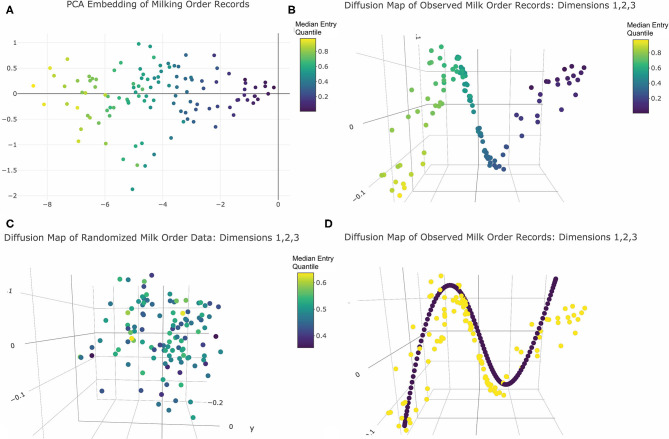
Dimension reduction of milk order records colored by median entry quantile value: (A) PCA embedding returns one principal axis reflecting each cows central moment of entry position. (B) The first three significant axes of diffusion map embeddings reveals a clearly linear underlying geometry reflecting central moment. (C) Diffusion map embeddding of data from the simulation of purely random queue formation recovers no distinctive geometry. (D) Harmonic series (purple points) imposed over observed cow records (yellow points) reveal curvilinear geometry is a embeding artifact. Note: Interactive versions of 3D plots are availble in Supplemental Materials.